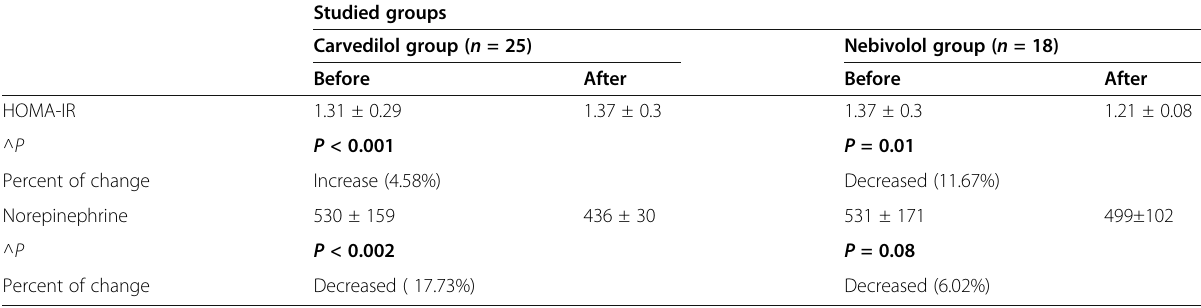
Table 4 Comparison between both